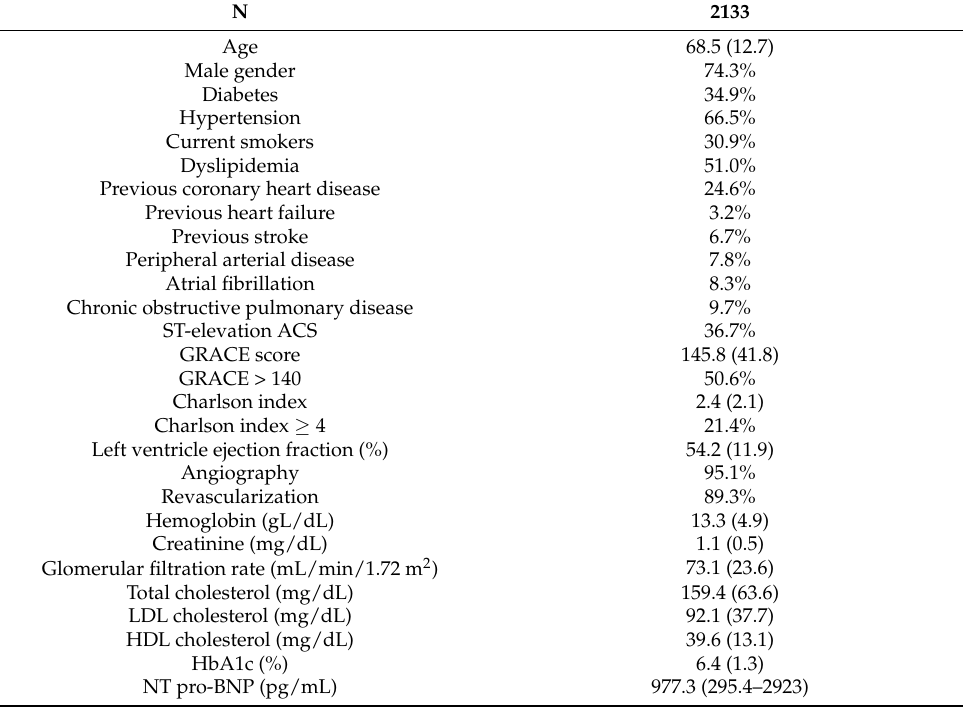
Table 1. Overall characteristics of the